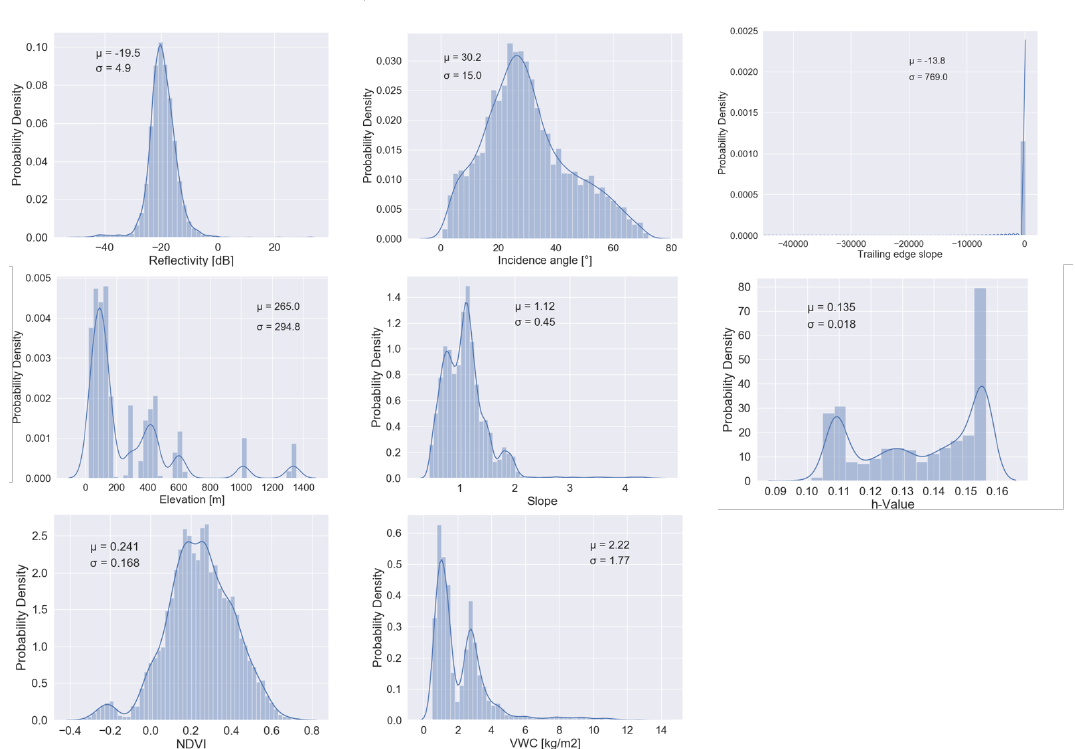
Figure 6. Distributions of the input features (before quality control flags applied). Application of quality controls did not result in large variations. Distribution statistics are also given in each